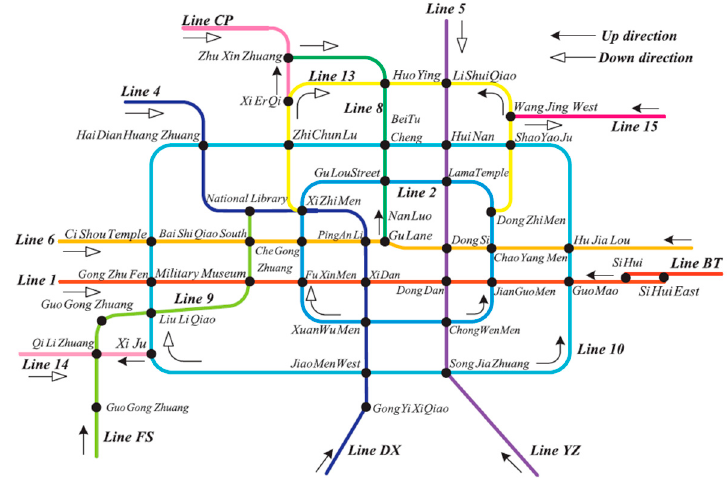
Figure 4. Beijing rail transit lines [49].